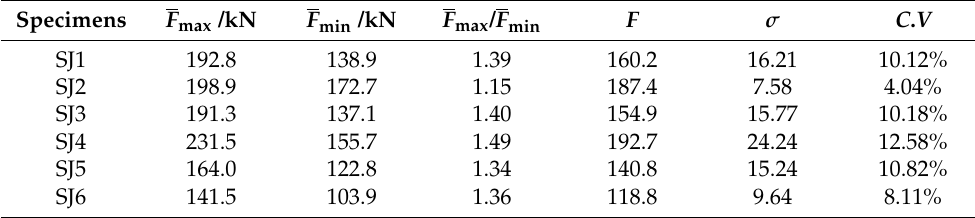
Table 3. Friction analysis of the friction energy dissipation composite chord